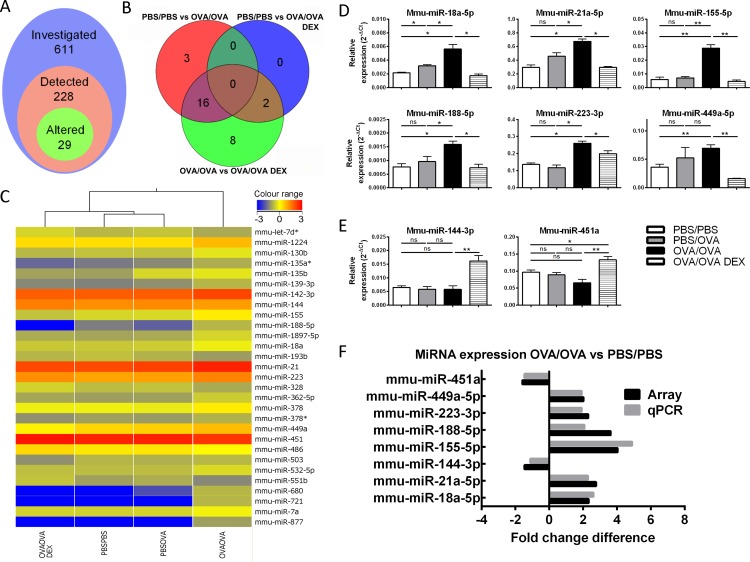
MiRNA profiling identifies differential miRNA expression in lungs of allergic mice.Expression of 611 miRNAs was investigated in whole lung samples by microarray. 228 miRNAs were detected in the lungs, with 29 altered between experimental groups (A). Venn diagram of statistically-significant differentially expressed miRNAs (fold-change ≥2) between PBS/PBS (PBS) and OVA/OVA, PBS/PBS and OVA/OVA DEX (DEX) and OVA/OVA and OVA/OVA DEX (B). Hierarchical cluster analysis of treatment conditions based on differentially expressed miRNAs. Heat-map representation of normalised expression levels for differentially expressed miRNAs. The boxes in colour indicate the normalised intensities of miRNA expression, with blue indicating low and red indicating high expression (C). qPCR detection of 6 altered miRNAs (D) and two DEX-responsive miRNAs (E). Expression is normalised relative to control RNA sno202. Fold changes for selected miRNAs is graphed for both microarray and qPCR analysis (OVA/OVA versus PBS/PBS) (F). Error bars represent SEM (n = 6 animals/group). Mann-Whitney test was used to compare two groups with another. P values of less than 0.05 are indicated by * and less than 0.01 by ** and less than 0.001 by ***.